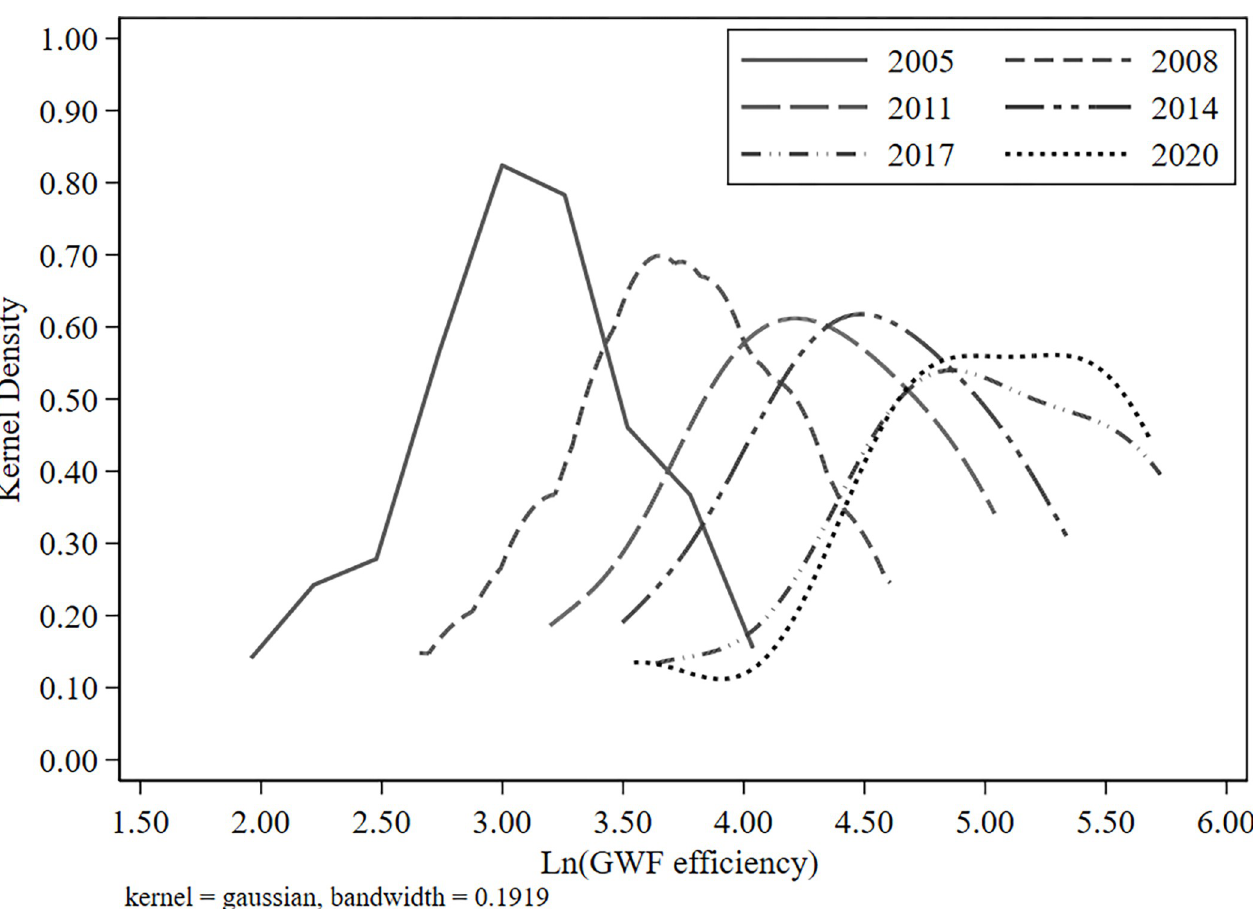
Fig 4. Kernel density estimation of GWF